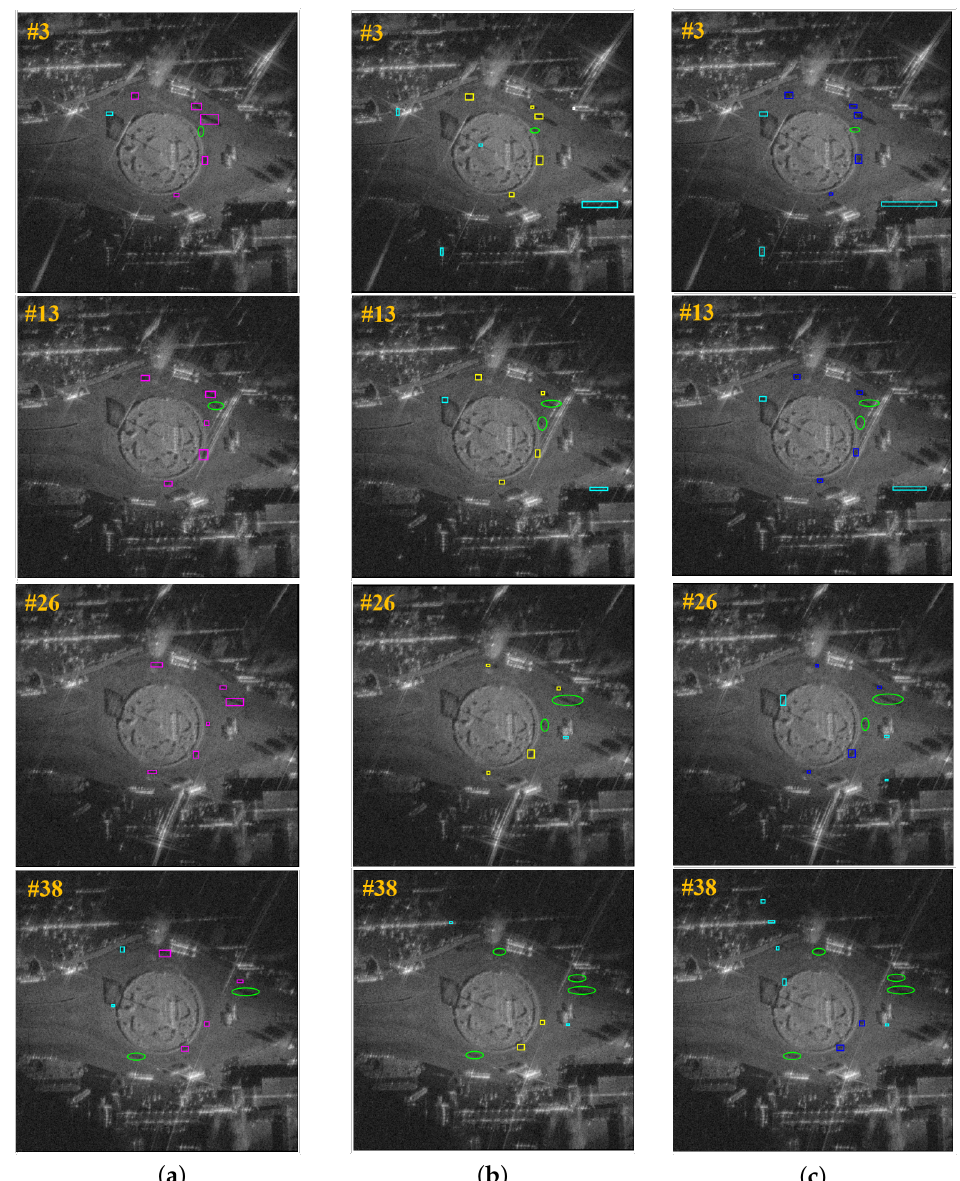
Figure 9. Detection results of different frames by different methods. ( a ) Detection results on the 3rd, 13th, 26th, and 38th frames by the LRSD-BIIANS method, which are labeled by pink rectangles. ( b ) Detection results on the 3rd, 13th, 26th, and 38th frames by the LRSD-CFAR method, which are marked with yellow rectangles. ( c ) Detection results on the 3rd, 13th, 26th, and 38th frames by the MEAN-CFAR method, which are labeled by blue rectangles. The cyan rectangles represent false alarms and the green circles are missing